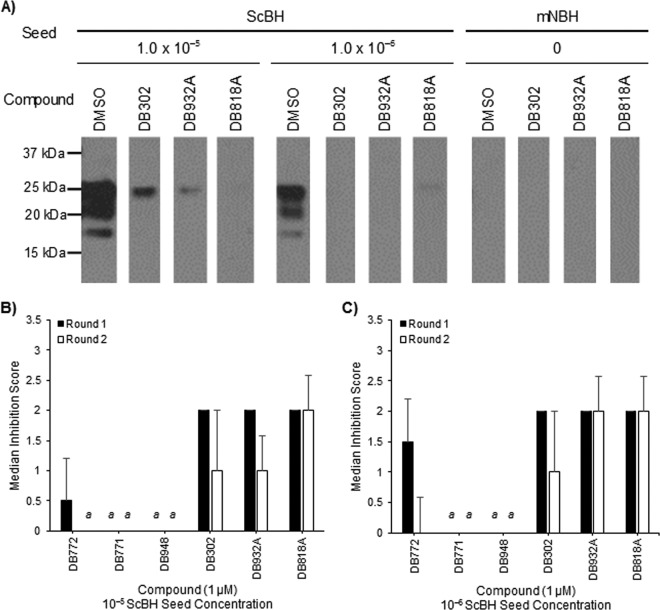
Selected DB compounds inhibit PrPSc-seeded misfolding during serial PMCA assay. The inhibition of PrPSc-seeded misfolding was evaluated by sPMCA assay by treating mNBH with 1 μM indicated compound. Reaction mixtures were collected at each round and tested for PK-resistant PrPSc by immunoblotting, and band intensities were analyzed as previously described (Fig. 5). (A) A representative immunoblot from samples collected at round 2n is demonstrated. (B and C) Percent reduction categorical scores were evaluated from reaction mixtures seeded with 10−5 (B) or 10−6 (C) dilutions of 10% ScBH. Data columns represent the median score ±1 standard deviation. a, all three replicates scored 0.